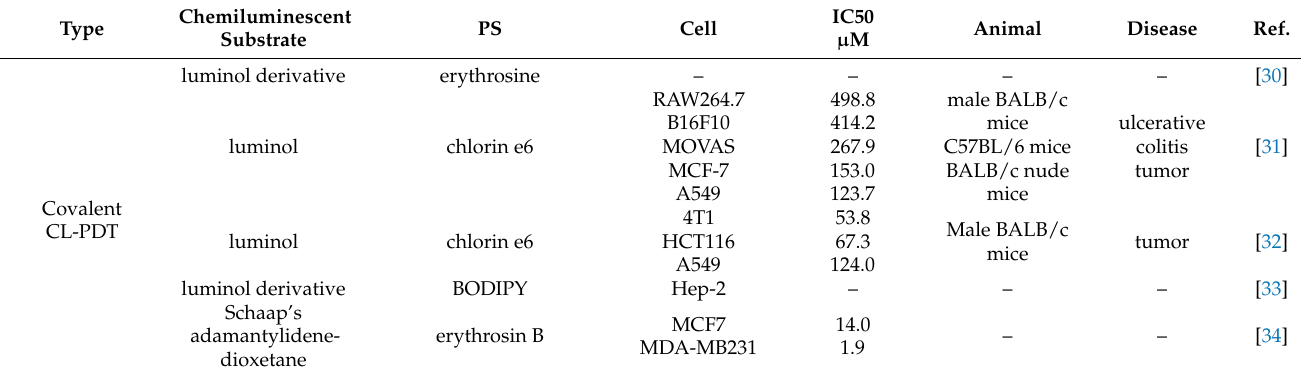
Table 1. Available CL-PDT systems.